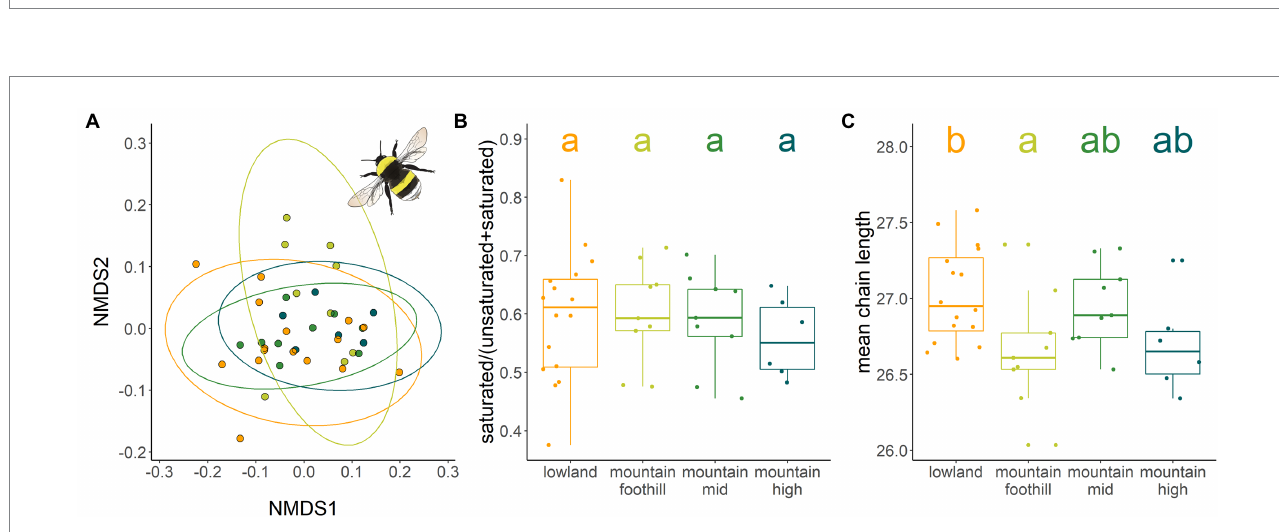
FIGURE 5 Differences in CHC profiles of Bombus lucorum translocated to four climatic different locations: warm and dry lowland region (orange), and mountain foothill (light green), mountain mid (green) and mountain high (blue; see Figure 1) in a cool and wet region. (A) Similarity of CHC profiles of individuals displayed in a two-dimensional graph by non-metric multidimensional scaling (NMDS) based on Bray-Curtis distances. Dots represent CHC profiles of individuals, dot colors the respective locations. The closer the dots, the more similar the CHC profile. Ellipse lines assuming a multivariate t-distribution, are based on the variance observed among each group of samples are presented. Non-metric multidimensional scaling revealed no differences in CHC profile compositions. (B) Proportion of saturated components. (C) Mean chain